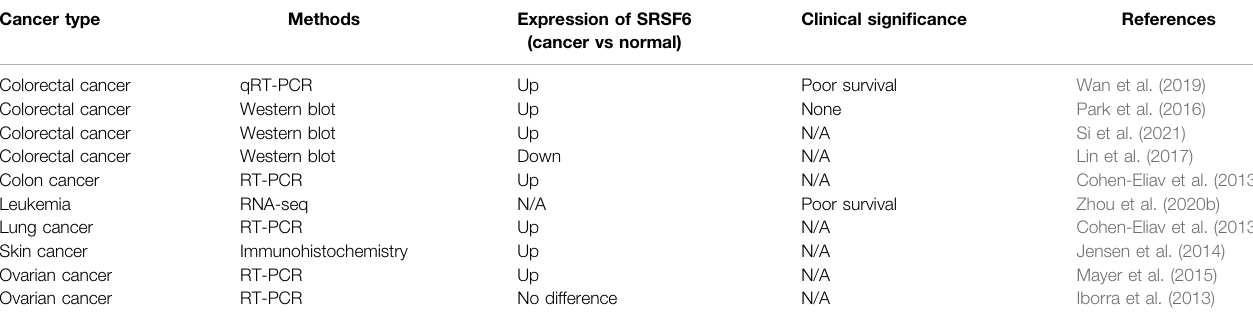
TABLE 1 | Expression and clinical signi fi cance of SRSF6 in